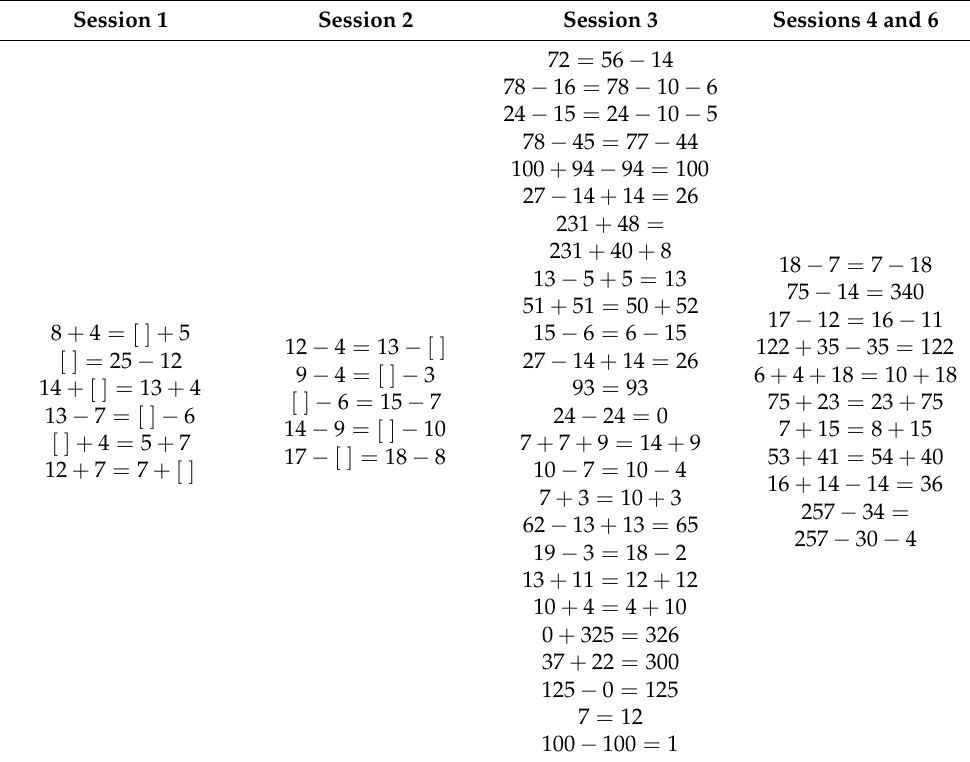
Table 2. Equalities used in sessions 1, 2, 3, 4, and 6.